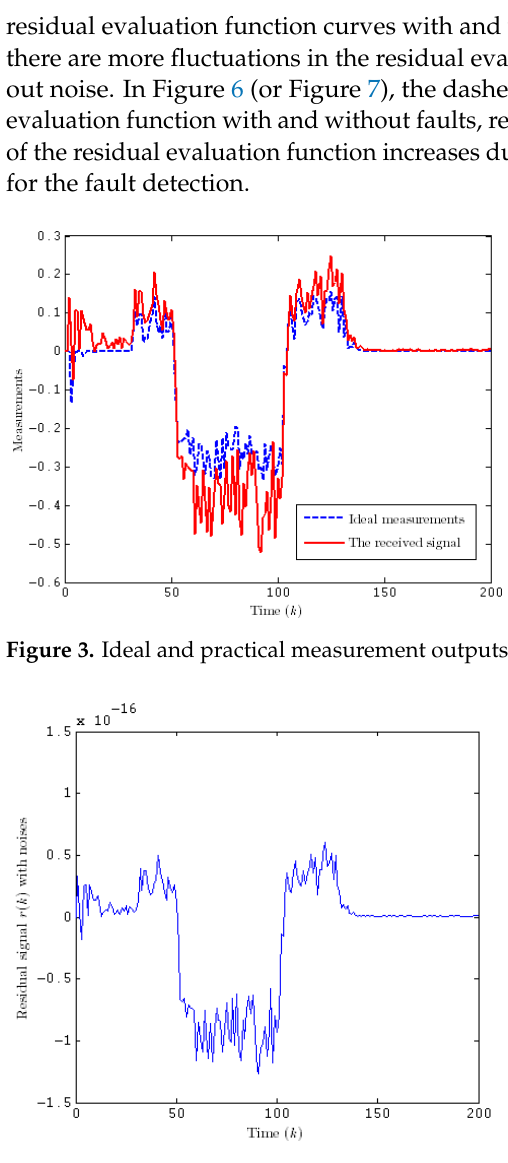
Figure 4. Residual signal with noises.